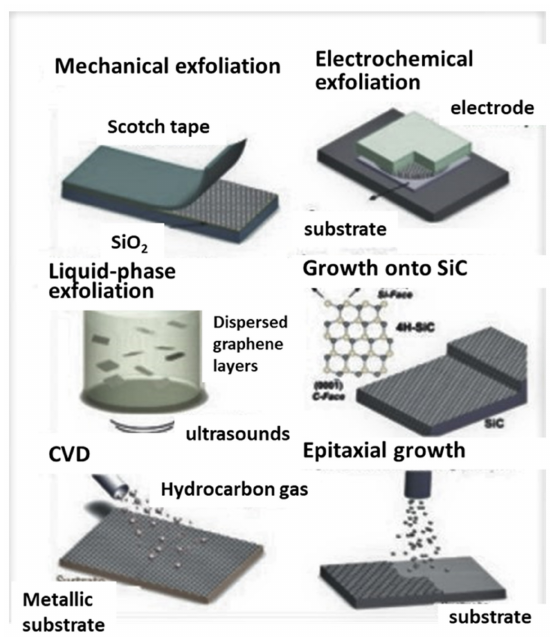
Figure 3. Most typical techniques for graphene synthesis.